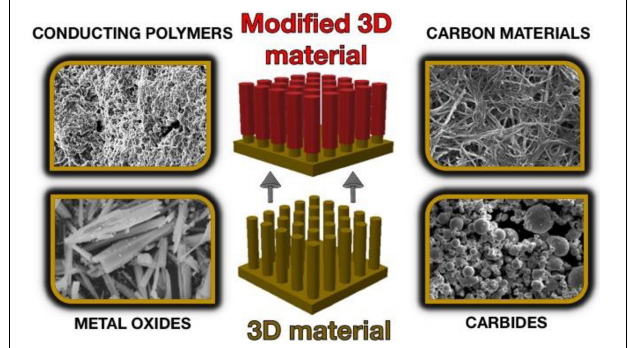
FIGURE 6 | Schematic illustration of non-template-based 3D materials. SEM pictures adapted from Hayashi and Hakuta (2010), Deng et al. (2015), Tomczykowa and Plonska-Brzezinska (2019), and He et al. (2020) under the Creative Commons CC BY license.